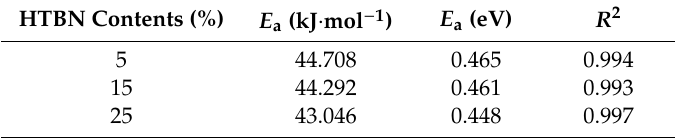
Figure 6. Interfacial polarization of the DGEBA-MeHHPA-HTBN and DGEBA-PPD-HTBN at 20 °C. The relaxation time ( τ ) follows the Arrhenius laws and fitting results are shown in Table 1. Through the comparison of the samples with three di ff erent filler contents, the apparent activation energy ( E a ) declines with the increase of filler contents. Therefore, the interfacial polarization is easier to establish in a high filler concentration system. Table 1. Arrhenius fitting results of relaxation time of the interfacial polarization.